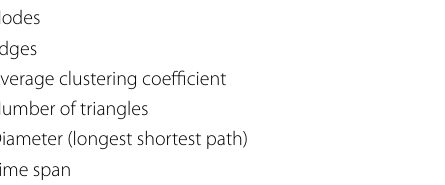
Table 7 Statistics of the Whole-graph